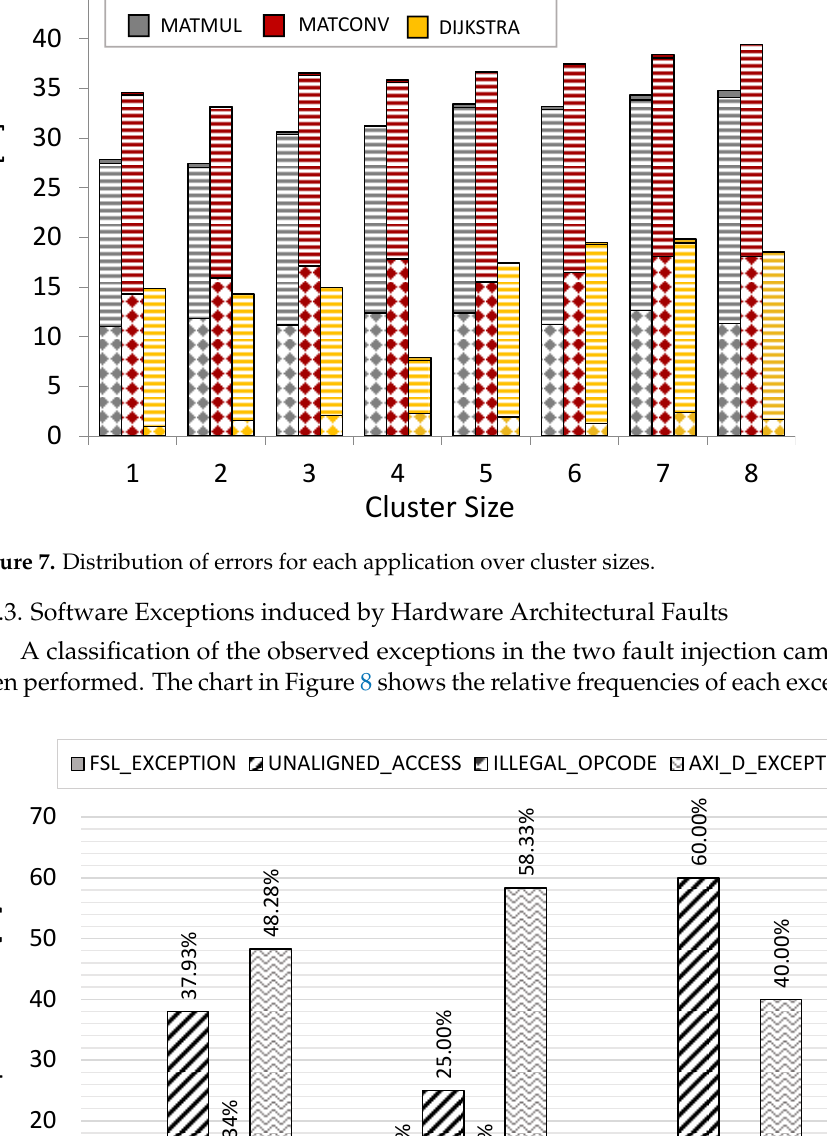
Figure 8. Relative frequency of the exception types resulting from the two fault injection campaigns.